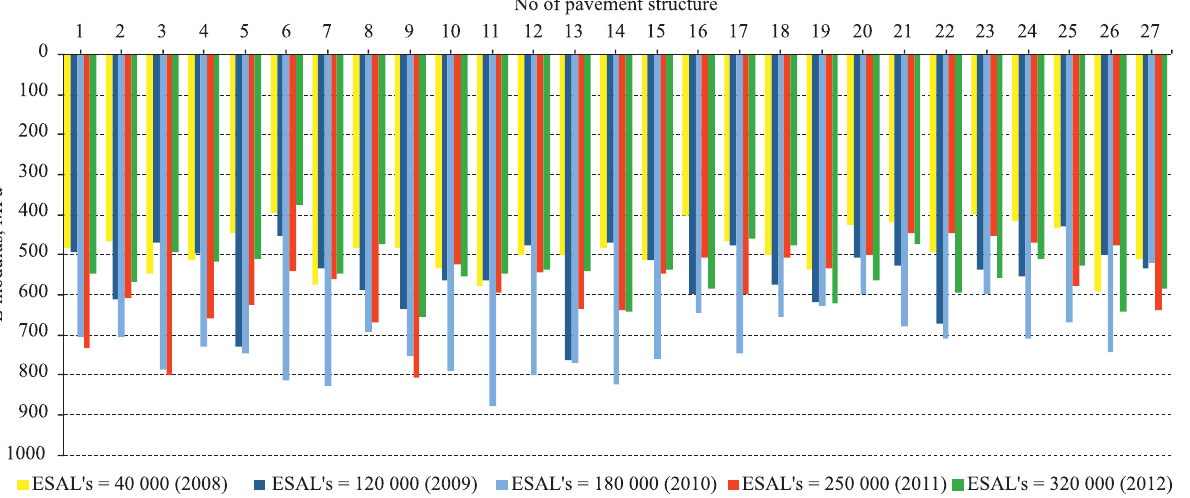
Fig. 5. Equivalent stiffness modulus E of pavement structures measured in spring with Benkelman Beam in the rut of loaded traffic